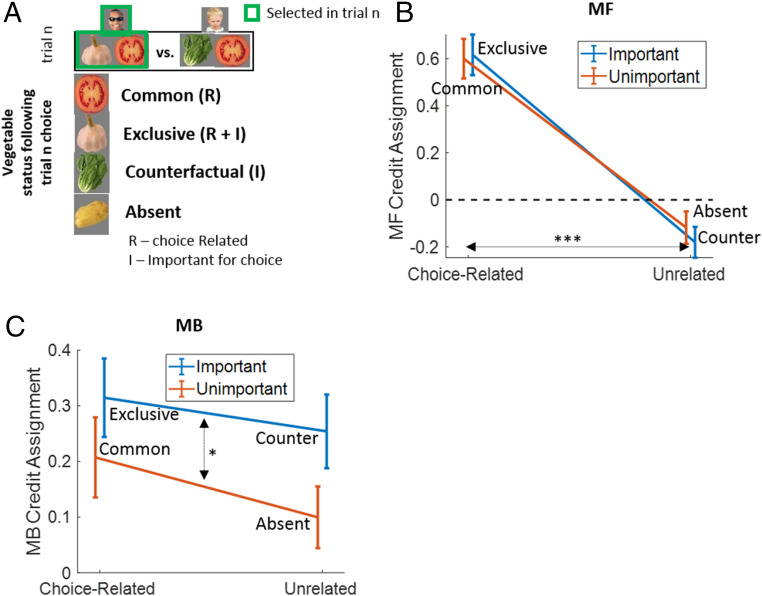
Signatures of MF and MB CA. (A) During a post-choice reward-feedback stage, outcomes were designated as Common, Exclusive, Counterfactual, and Absent. Two outcomes were choice-related (R) and two are were “important” (I) with respect to MB deliberations. (B) MFCA parameters based on the full model. The choice-relatedness effects demonstrate CM-based guidance of MFCA. Furthermore, the mean negativity for choice-unrelated outcomes implicates negative MFCA for choice-unrelated outcomes. (C) Similar to B but for the MB system. The “importance” main effects show that MBCA is enhanced for important outcomes. Error bars correspond to SEM across participants calculated separately in each condition (n = 42). *P < 0.05, ***P < 0.001. P values were calculated based on mixed-effects logistic regression models.